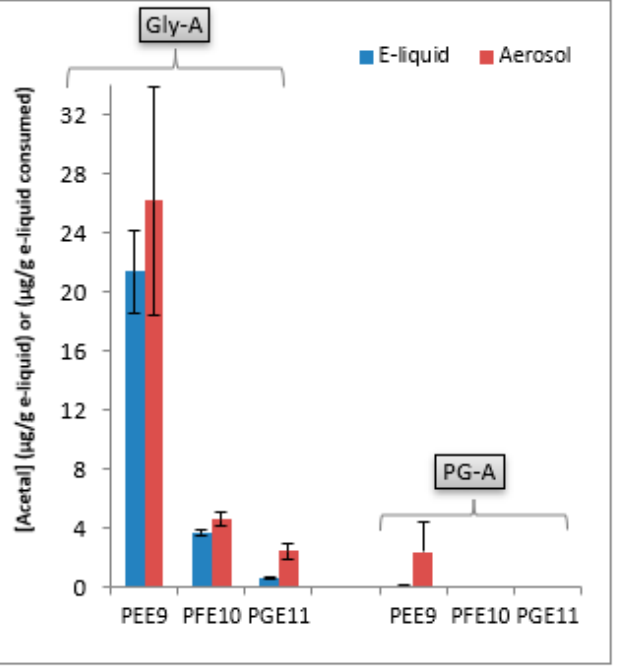
Figure 6. Gly-A and PG-A average concentrations (n = 4) measured in e-liquid (µg/g of e-liquid) and e-cigarette aerosol (µg/g of e-liquid consumed) Pod device category: Gly-A significantly increased in PGE11 aerosol while PG-A was only detected in PEE9. Error bars represent the standard deviation of each dataset.